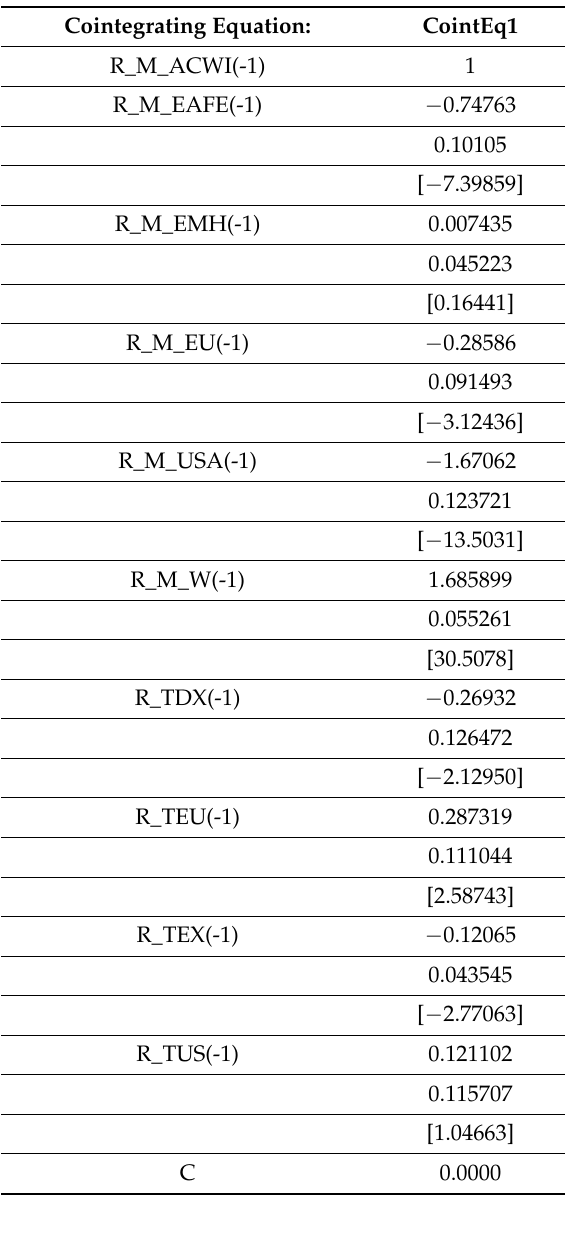
Table 5. Results from vector error correction model applied for conventional and sustainable